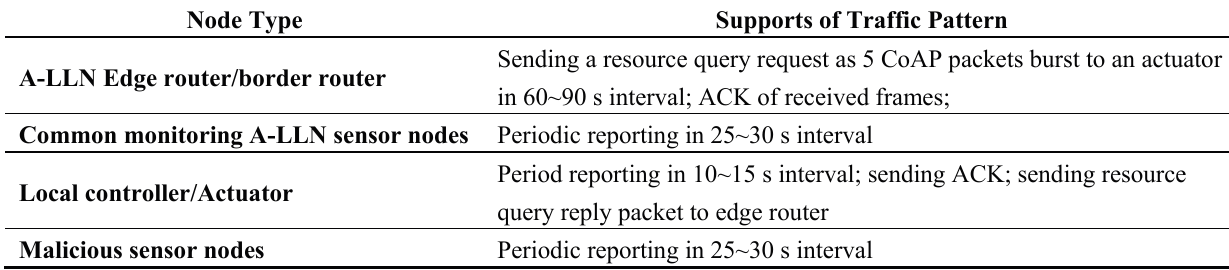
Table 5. Traffic patterns of the nodes with different logical roles in an